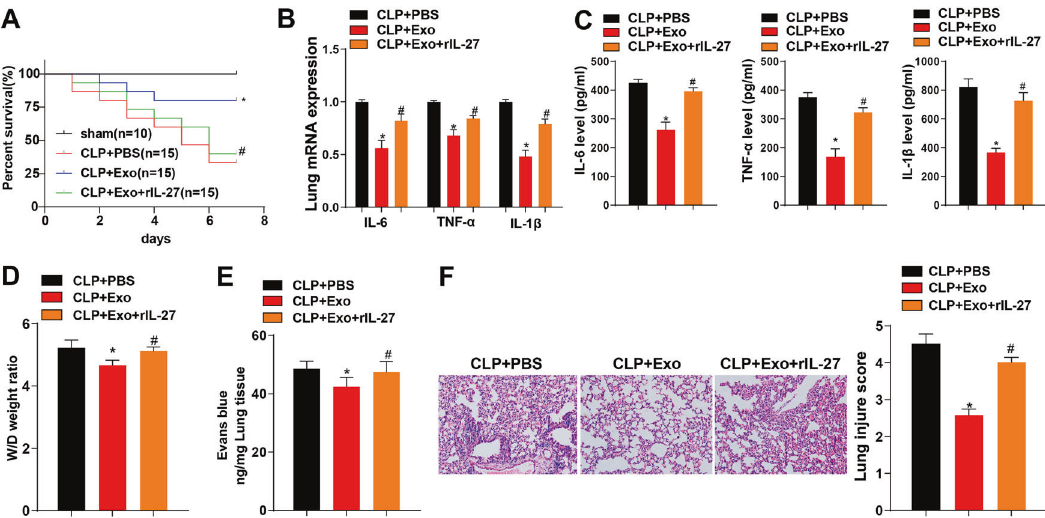
Fig. 5 ADMSC-exosomes alleviated sepsis-induced lung injury by mediating the secretion of IL-17. A The survival rate of mice within 7 days (sham group: N = 10; other groups: N = 15). B The mRNA expressions of IL-6, TNF- α , and IL-1 β in mouse lung tissue were detected using RT-qPCR 24 h after CLP induction, N = 8. C The protein contents of IL-6, TNF- α and IL-1 β in mouse lung tissues were detected using ELISA. D The wet/dry ratio was used to calculate the formation of pulmonary edema, N = 8. E 24 h after CLP, Evans blue dye was injected to measure pulmonary vascular leakage, N = 8. F The morphological changes of lung were measured (scale bar = 25 μ m) and the tissue injury was quantitatively analyzed ( N = 8) using HE staining. Measurement data are depicted as mean ± SD. One-way ANOVA was employed for the comparisons among multiple groups, followed by Tukey ’ s multiple comparisons test. * p < 0.05 vs . CLP + PBS group; # p < 0.05 vs . CLP + Exo group. Kaplan-Meier method was used to calculate the survival rate. Log-rank test was used for univariate